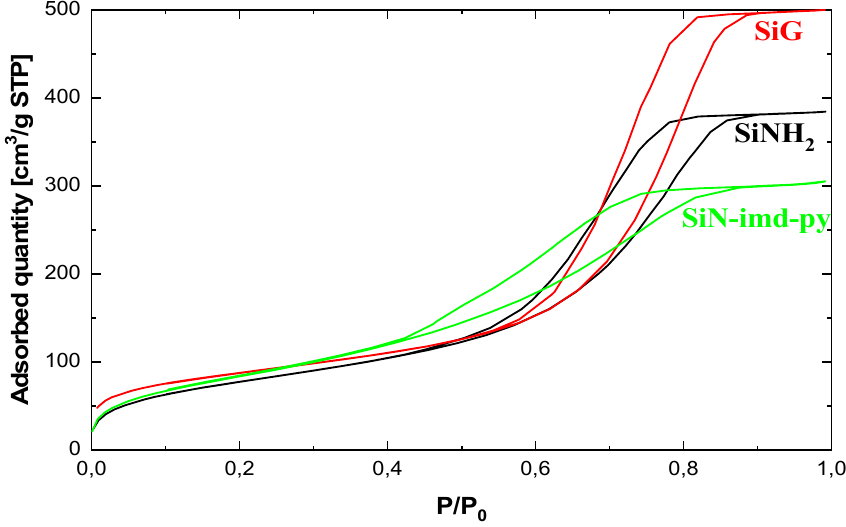
Figure 4. Nitrogen adsorption–desorption isotherm plots of SiG , SiNH2 and SiN-imd-py Figure 4 . Nitrogen adsorption–desorption isotherm plots of SiG , SiNH2 and SiN-imd-py .